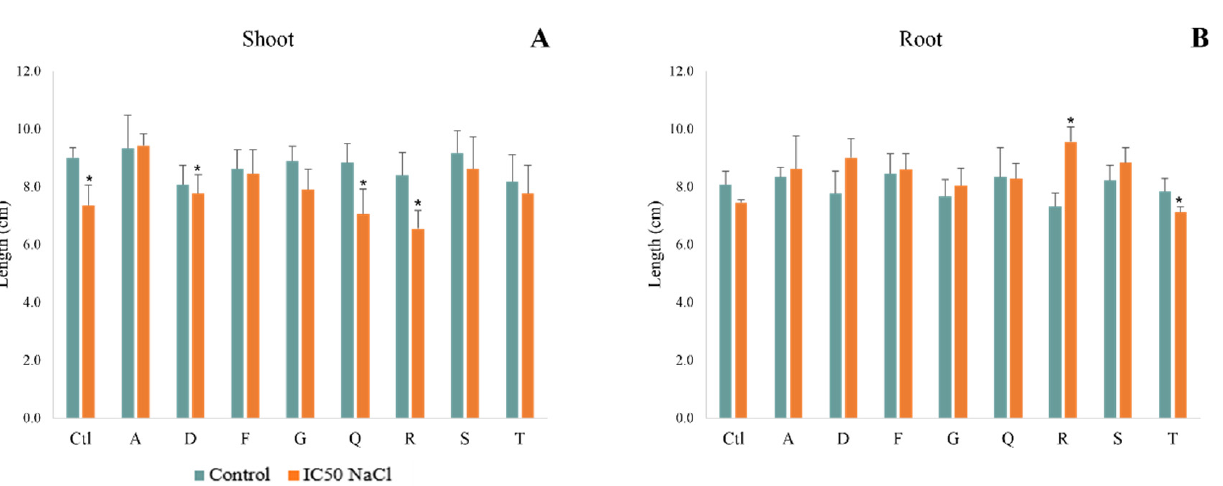
Figure 4. Maize plants grown for 7 days in non-saline and saline (1% NaCl) conditions. Biometric parameters: ( A ) fresh weight and ( B ) length of shoots; Non-stressed (greenish bars) and salt-stressed (orange bars) plants were inoculated with different strains: Pantoea sp. (A); Pseudomonas sp. (D); Acinetobacter sp . (F); Stenotrophomonas sp. (G); Pseudomonas sp. (Q); Rhizobium sp. (R); Stenotrophomonas sp. (S); Pseudomonas sp. (T). Values are means of three replicates + standard deviation. Significant differences compared to control (non-inoculated and non-salt exposed plants) were marked with single asterisks ( p < 0.05). For means, standard deviation and statistical significance see Supplementary Table S4.